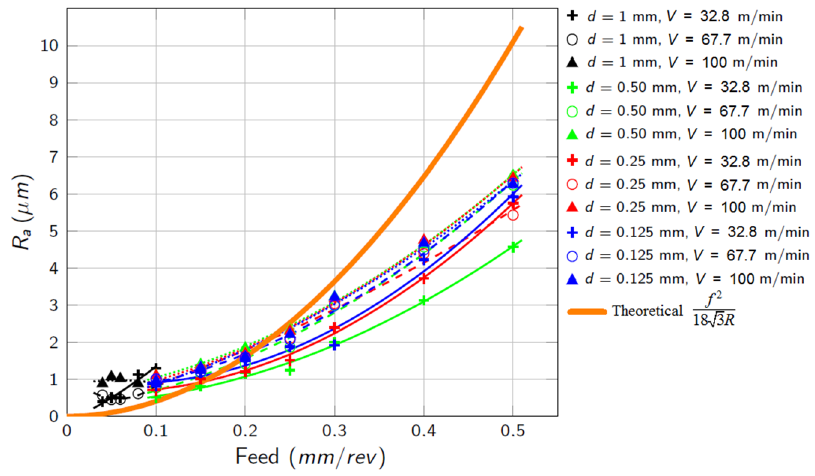
Figure 16. R a evolution under LIL condition tests. V is the cutting speed and d is the depth of cut.